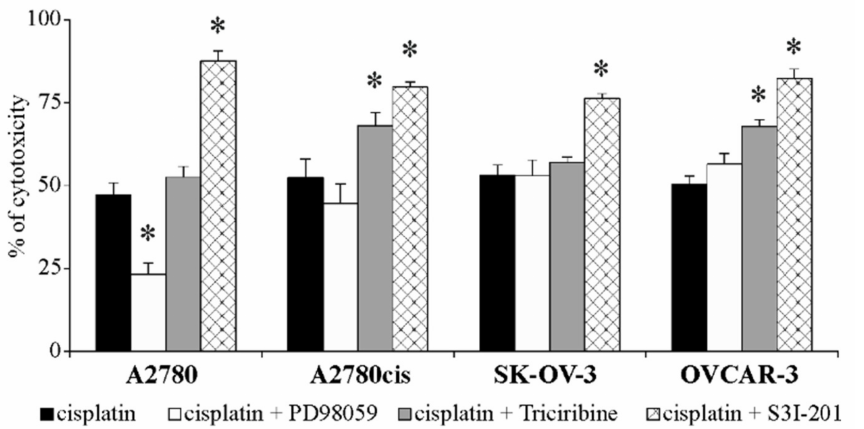
Figure 9. The viability of A2780, A2780cis, SK-OV-3 and OVCAR-3 cells treated with the combination of cisplatin and inhibitors. All cell lines were cultured with cisplatin (6 or 20 or 32 or 41 µ M) alone or in combination with PD98059 (50 µ M) or Triciribine (50 or 100 µ M) or S3I-201 (50 or 100 µ M) or left untreated (control) for 48 h. Initially, all cell lines were pre-treated with appropriate inhibitors for 1 h before addition of cisplatin. Cell viability was determined with MTT assay and is presented as the mean % of cytotoxicity ± SD from five independent experiments ( n = 5). * Statistically significant change in cell viability: PD98059 + cisplatin or Triciribine + cisplatin or S3I-201 + cisplatin vs. cisplatin, p ≤ 0.04 (Wilcoxon’s singed rank